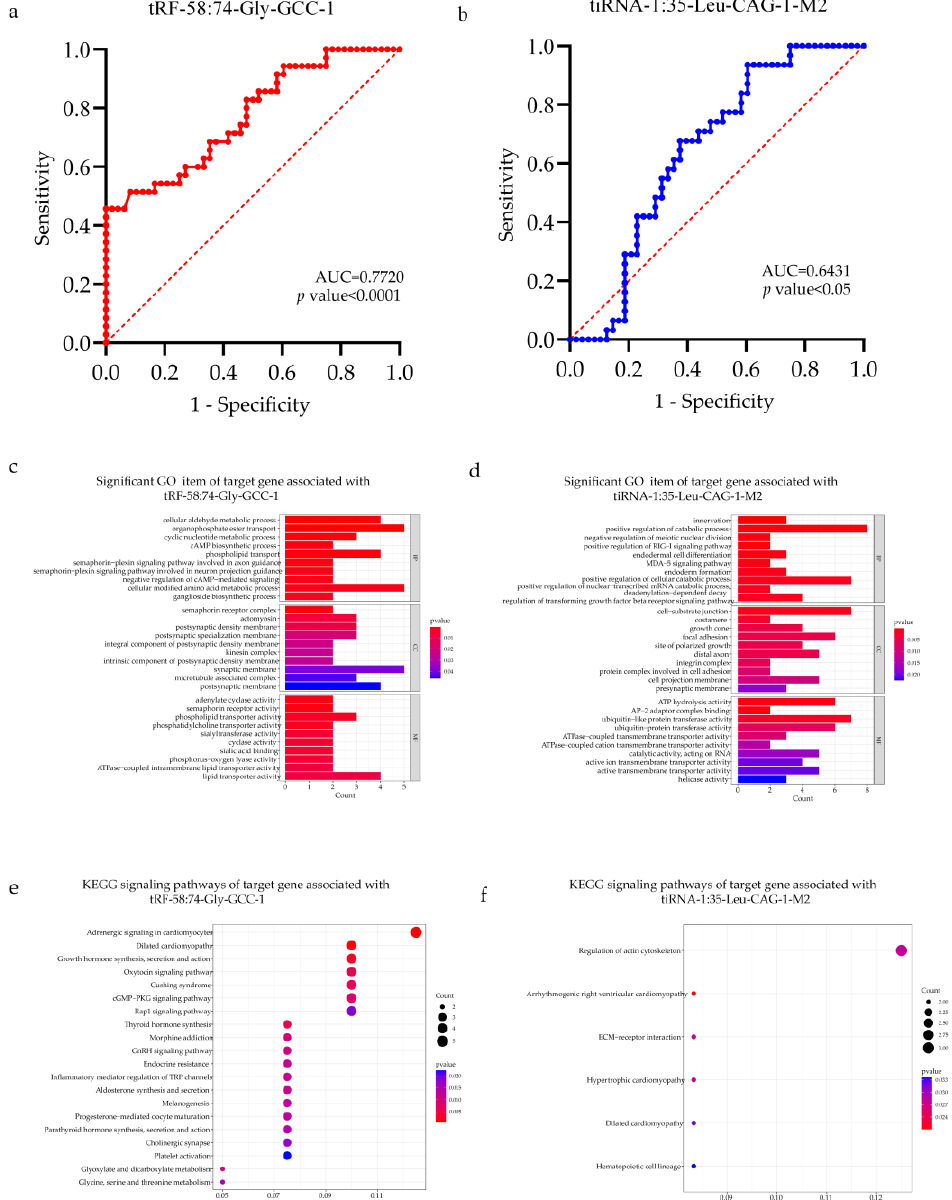
Figure 4. ROC curve, GO and KEGG pathway analysis of specific tRFs/tiRNAs. ( a , b ) The vertical axis is sensitivity, the horizontal axis is 1-specificity. AUC is a parameter used to measure the value of tRFs/tiRNAs in the diagnosis of fetal CHD. ( c – f ) GO and KEGG pathway analysis of tRF-58:74-Gly-GCC-1 and tiRNA-1:35-Leu-CAG-1-M2.